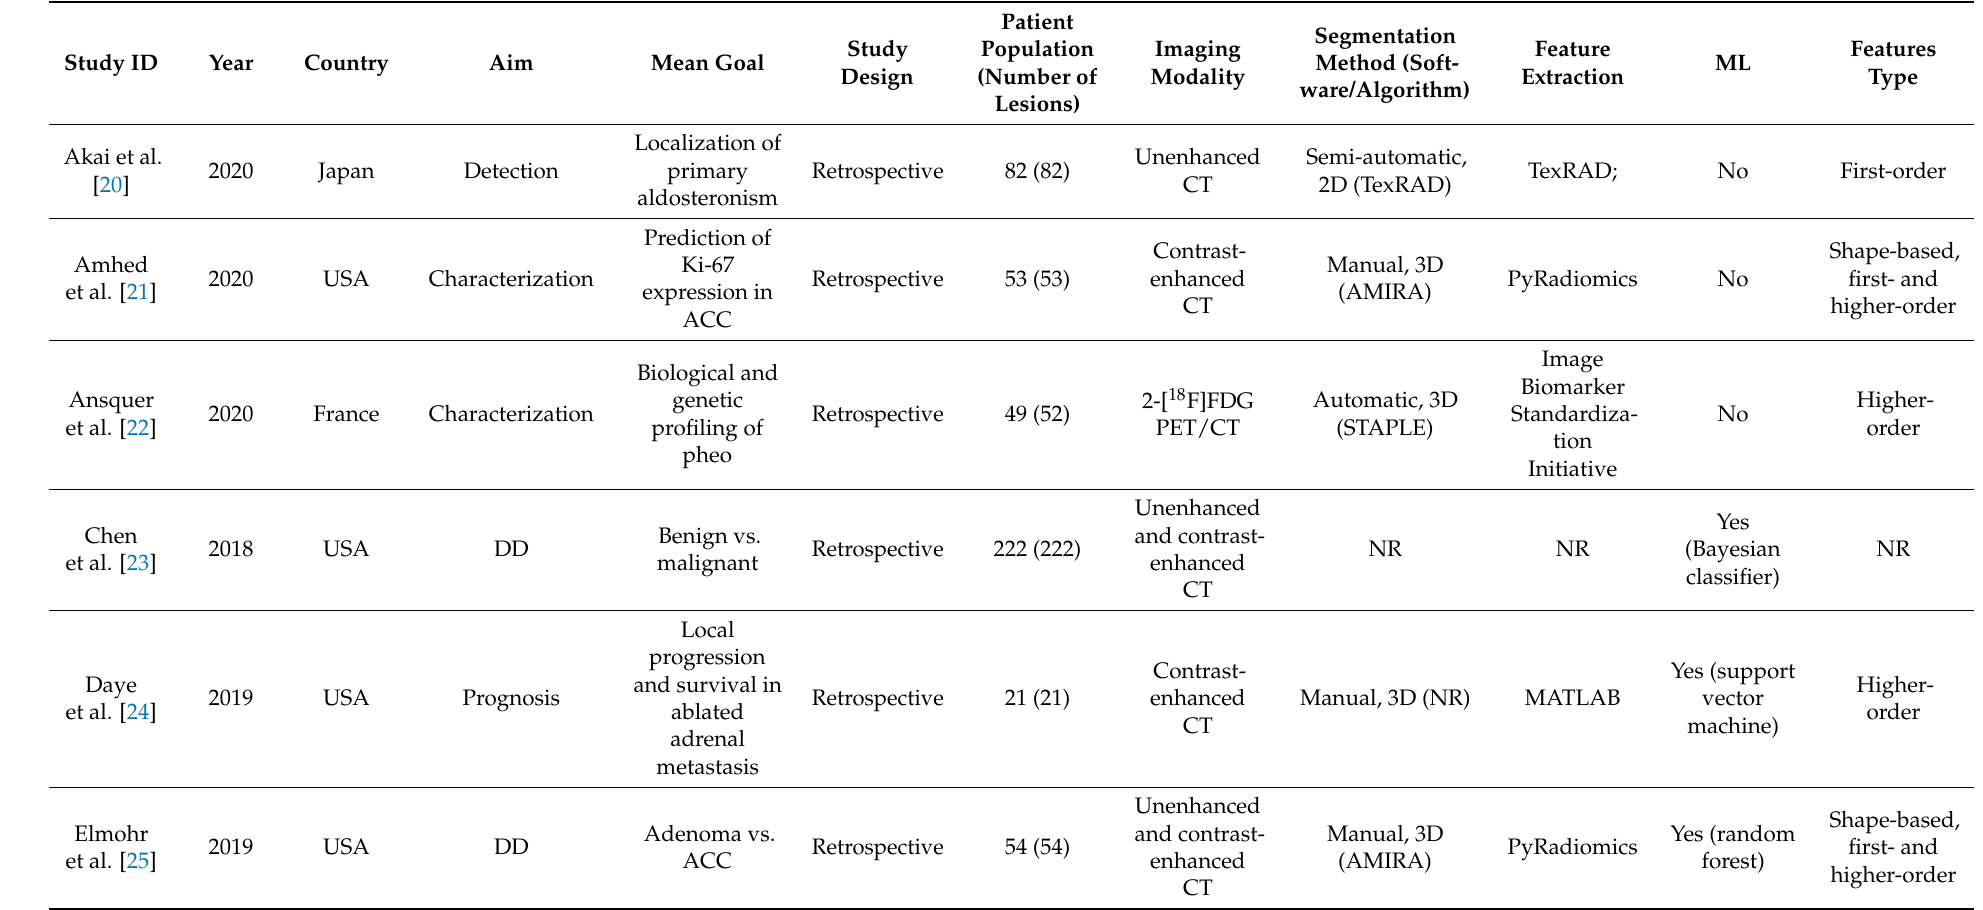
Table 1. Main characteristics of included